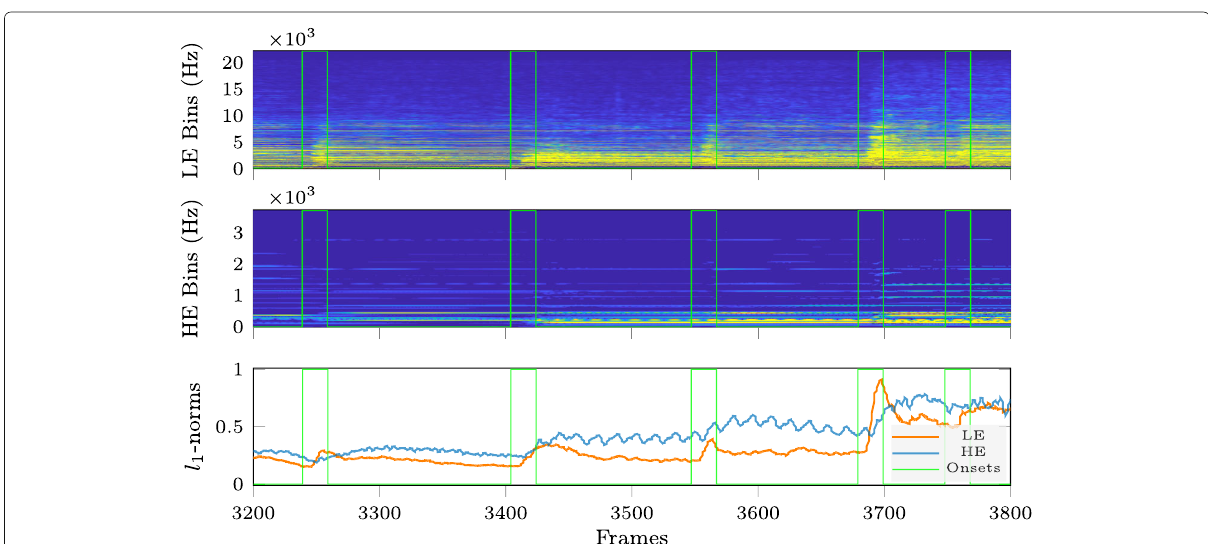
Fig. 3 Temporal variation of signal energy per frequency bin and of spectral sparsity for cello (non-vibrato) excerpt. Note onsets are indicated by vertical lines. (Top and middle) Low- and high-energy log-magnitude spectrograms. (Bottom) Low- and high-energy STFT log-magnitude coefficient vector (cid:4) 1 -norm